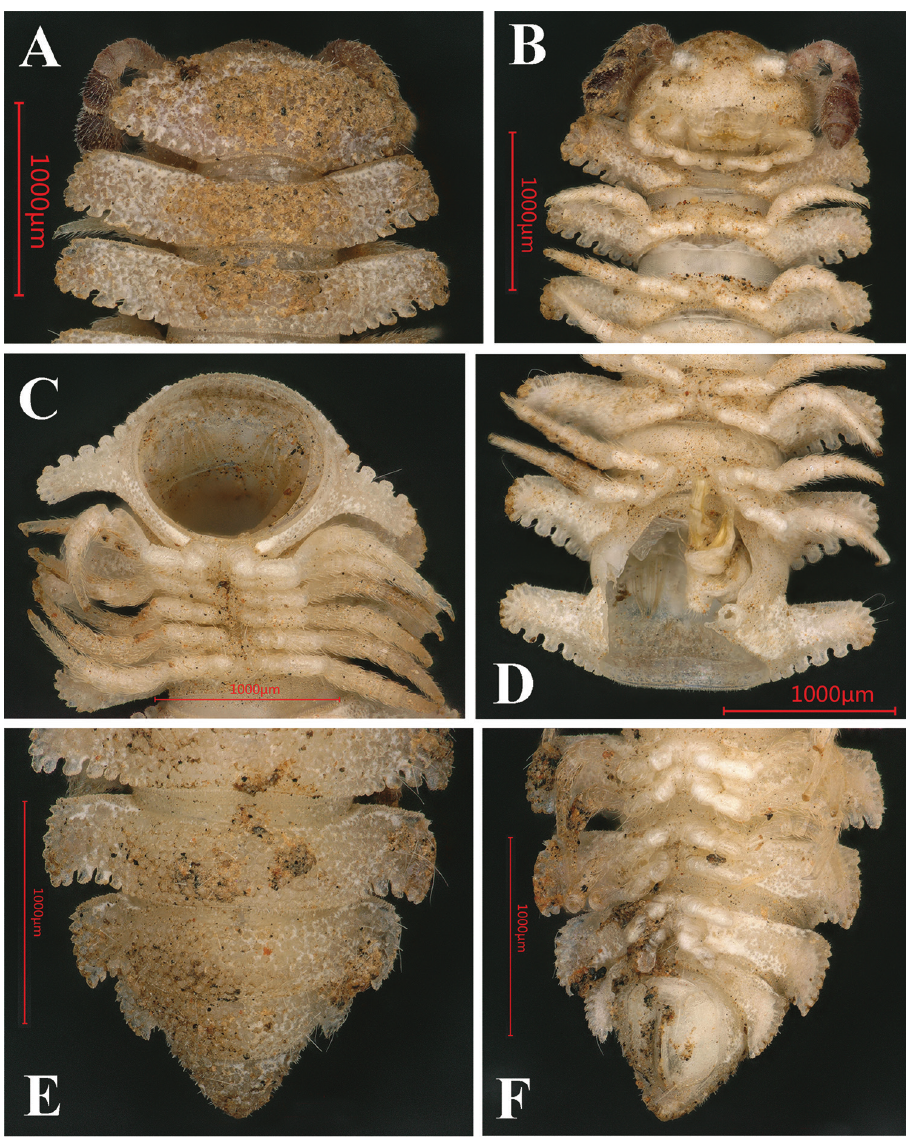
Figure 5. Trichopeltis intricatus sp. n., ♂ holotype. A collum and segments 2–3, dorsal view B head and segments 1–4, ventral view C cross-section of segment 10, caudal view D segment 5–7, ventral views E–F segments 16–19 and telson, dorsal and ventral views,